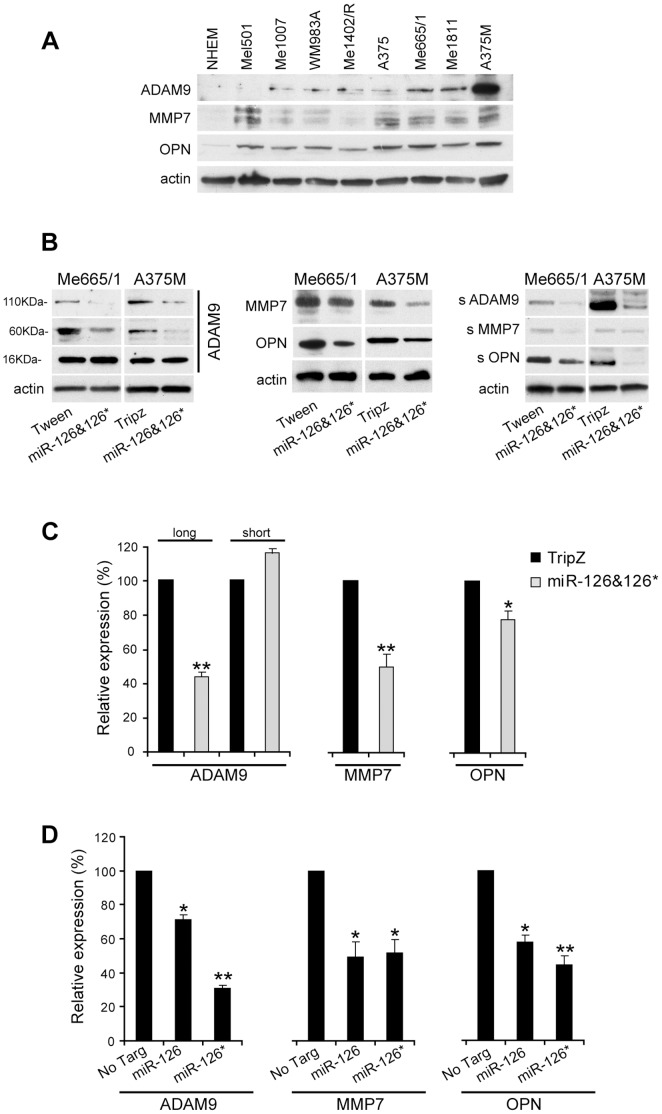
miR-126&126* target genes: ADAM9, MMP7 and OPN.Representative Western blot of A) ADAM9, MMP7 and OPN in normal human melanocytes (NHEM) and in a panel of melanoma cell lines, B) ADAM9 isoforms (left), MMP7 and OPN (middle) and corresponding secreted forms (right) in miR-126&126* versus empty vector-transduced Me665/1 and A375M cell lines. C) Representative Real-time PCR analysis of ADAM9 (left), MMP7 (middle) and OPN (right) mRNAs in the A375M cell line. The unresponsive short isoform of ADAM9 mRNA does not carry miR-126&126* binding sites in its 3′UTR. D) Relative expression values obtained by western blot analysis of ADAM9 (left), MMP7 (middle) and OPN (right) in A375M cells transfected with oligomers mimicking mature miR-126 or miR-126* vs non targeting (no Targ); GAPDH and actin were internal loading controls in RT-PCR and WB, respectively. Columns, of a minimum of two independent experiments; **P<0.001; *P<0.05.